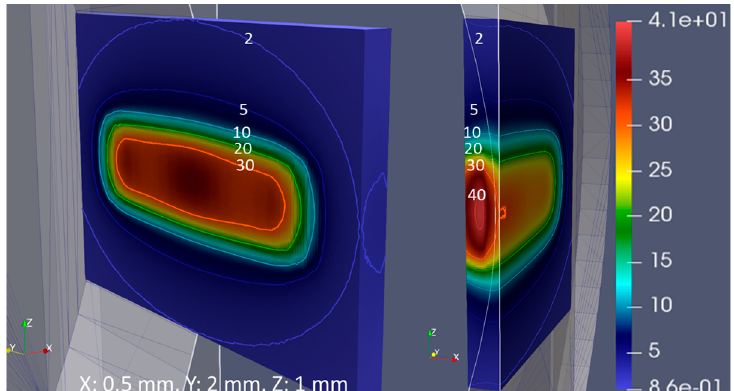
Figure 5. Plots of the DPA [dpa/fpy] mesh tally of footprint “20 × 5” over the high-DPA segment of the BP. Isometric view from inner BP is on the left, and the cut view through the BP’s center is on the right.